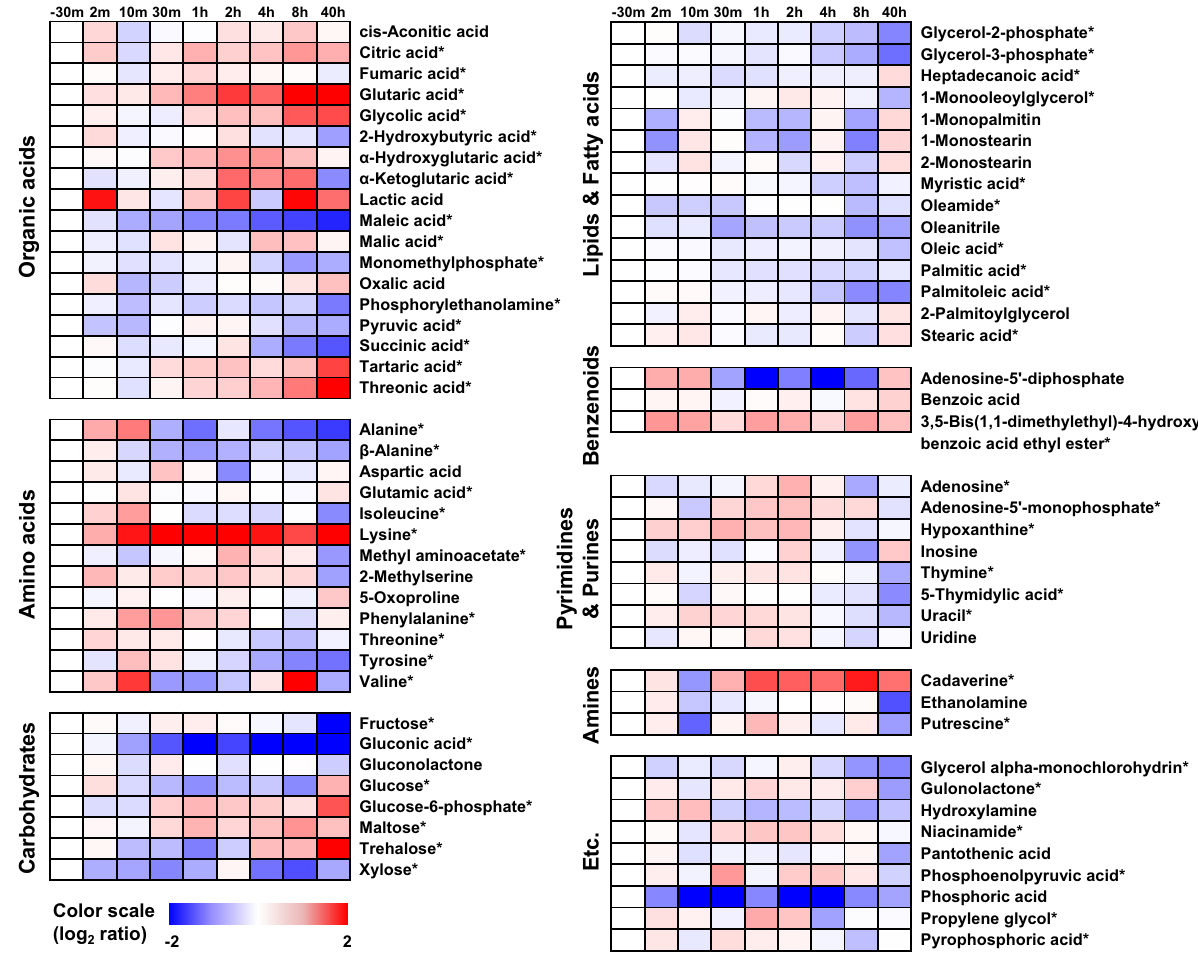
Figure 3. Time profiles of the intracellular metabolites under heat stress. Seventy-seven metabolites were identified via the GC-TOF–MS analysis and are listed in Supplementary Table S3. Fifty-seven of these metabolites that were significantly differentially expressed among the samples (VIP > 1.0 and p < 0.05) are indicated by asterisks. Fold-change was calculated as the relative abundance of each metabolite in every sample relative to that in the sample taken before the perturbation. The metabolic alternations are depicted as heatmaps on a log2